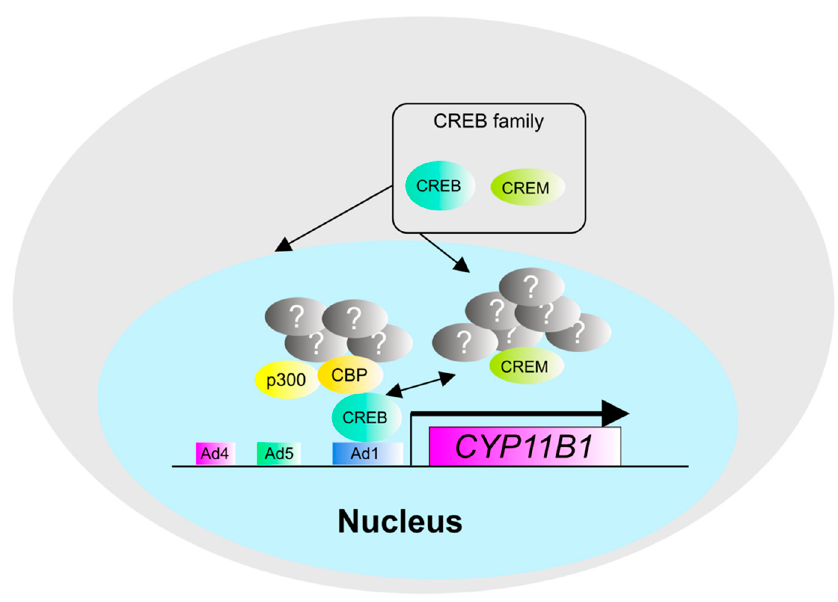
Figure 7. Transcriptional regulation of the CYP11B1 gene by the CREB family. The CREB family, including CREB and CREM, is involved in the regulation of gene expression of CYP11B1 , a cortisol synthase. CREB has been identified as a component of the transcription factor complex with p300 and CBP, but the other components are still unknown.